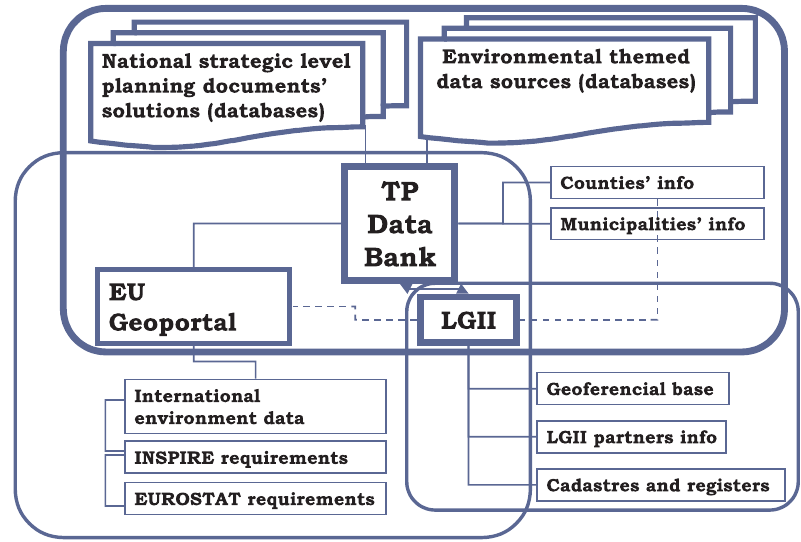
Fig. 4. The notion of the interaction of the data bank of territory planning in the context of the integrity while evaluating geography information infrastructure of Lithuania (LGII) and the European Directive Establishing an Infrastructure for Spatial Information in the European Community